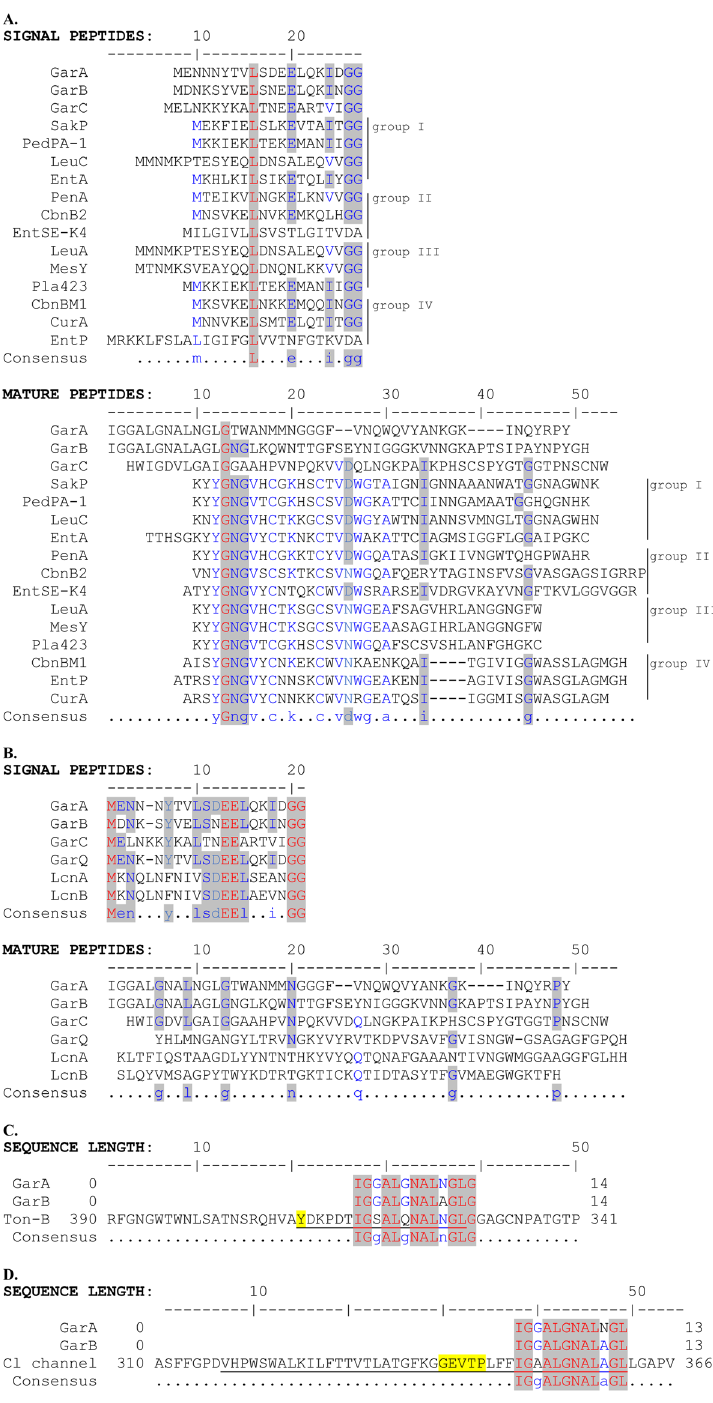
Figure 2. Multiple sequence alignment of the amino acid sequences of signal peptides and mature peptides of garvicin A, B, C and other Man-PTS-targeting bacteriocins: ( A ) subclass IIa bacteriocins, ( B ) subclass IId bacteriocins or channel-forming proteins: ( C ) Ton-B dependent receptor (Ton-B) and ( D ) voltage-gated chloride channel (Cl channel). Consensus amino acids are in red, partial consensus amino acids are in blue. Amino acids conserved between GarA, GarB, GarC and subclass IIa, subclass IId bacteriocins or transport proteins are highlighted by grey background. Conserved amino acids residues and underlined. Amino acids probably involved in the ligand-binding ( C ) and formation of Cl − selectivity filter ( D ) are highlighted by yellow background. The UniProt accession numbers are P38580 for carnobacteriocin B2 (CbnB2), P38579 for carnobacteriocin BM1 (CbnBM1), P0A311 for curvacin A (CurA), Q47784 for enterocin A (EntA), O30434